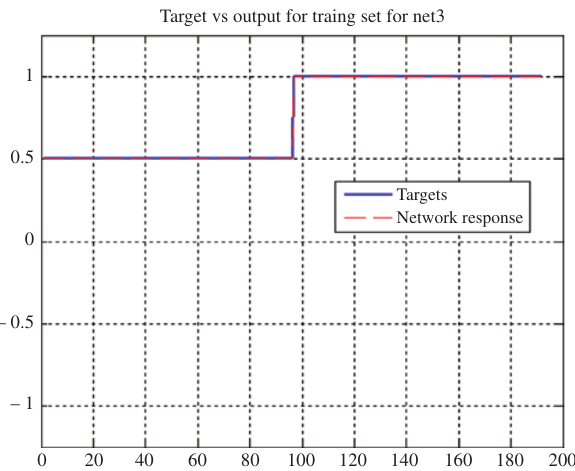
Figure 14: Target versus Output for Training Data Set for net3.